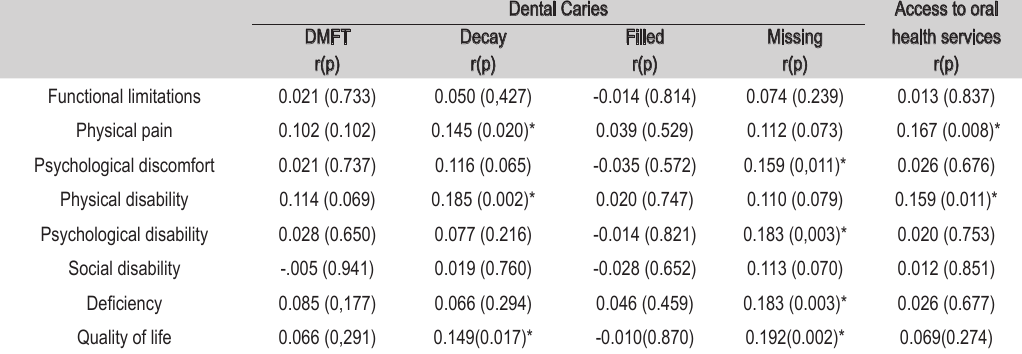
Table 4 - Spearman correlation (r) between dental caries, its components and access to oral health services with quality of life and its domains, Agudos, SP, 2012.